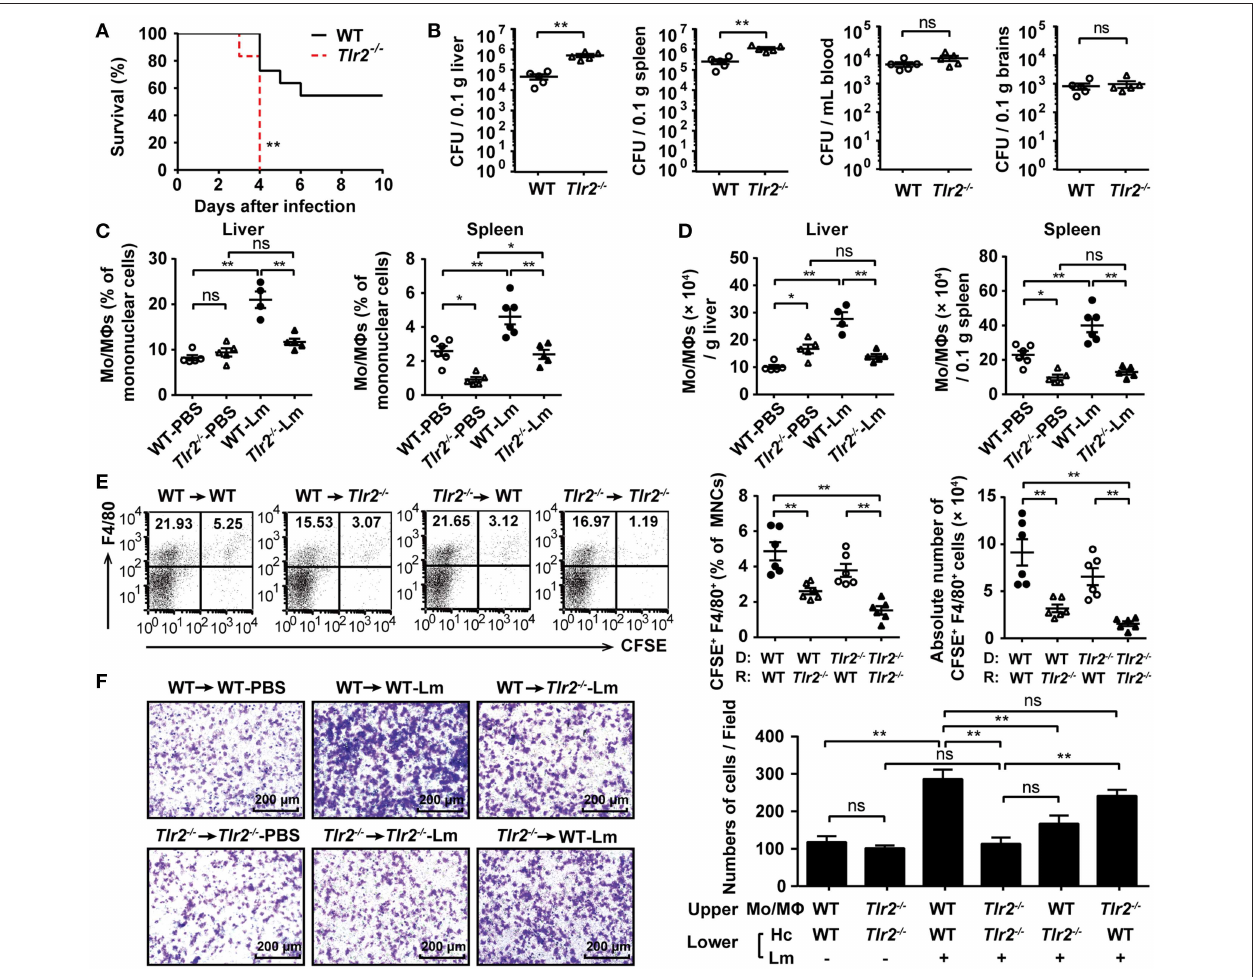
FIGURE 1 | TLR2 deficiency decreases hepatic Mo/M 8 infiltration in response to acute Lm infection. (A) Age-matched WT and Tlr2 − / − mice were i.p. infected with 1 × 10 6 CFU of Lm, and the survival rate of these mice was monitored (n ≥ 6, log-rank test, one representative of two independent experiments). (B) The bacterial burden was assessed by determining CFU numbers in the liver, spleen, blood, and brains 3 dpi ( n = 5). (C,D) The frequency (C) and absolute number (D) of Mo/M 8 s (CD11b + F4/80 + ) in the liver and spleen 2 dpi ( n = 5–6, one representative of two independent experiments). (E) WT and Tlr2 − / − mice were adoptively